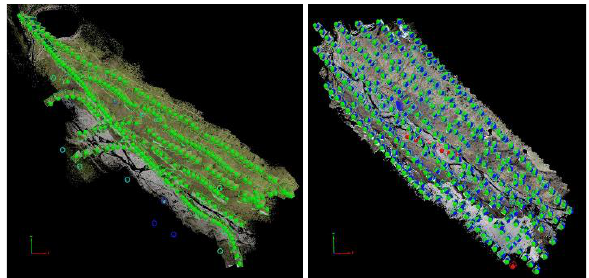
Figure 4. Photogrammetric blocks acquired in 2015 using a fixed-wing platform (left) and in 2019 using a multicopter platform (right).